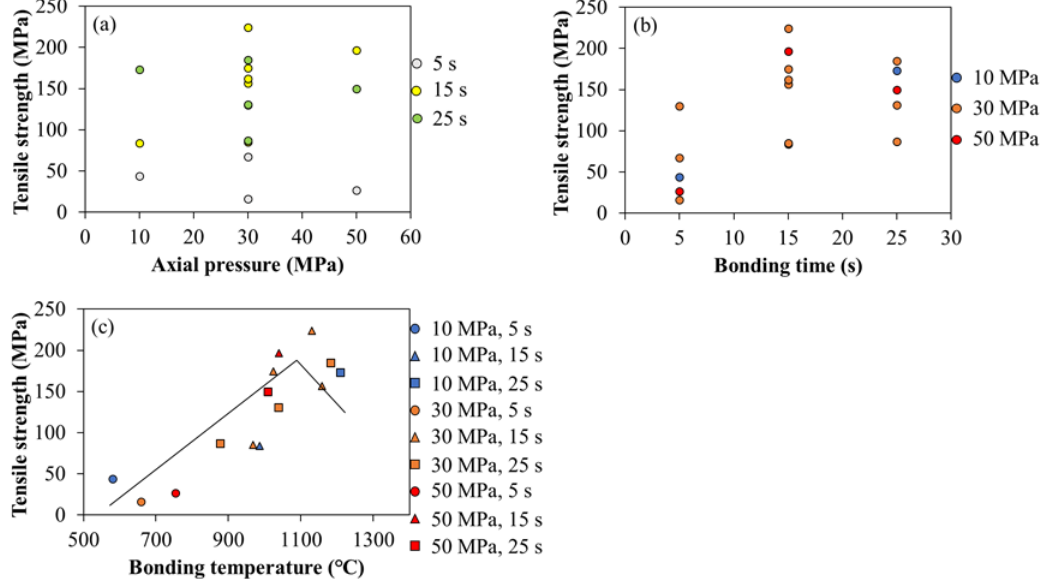
Figure 4. E ff ects of the ( a ) axial pressure, ( b ) bonding time, and ( c ) bonding temperature on the tensile strength of the joint.